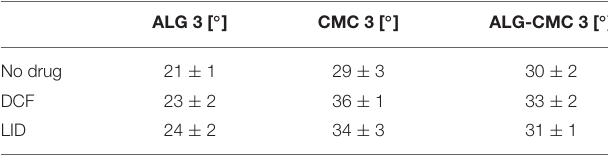
TABLE 1 | SCA(H 2 O) values of ALG, CMC, and ALG-CMC spin-coated multi-layers, incorporated with and without